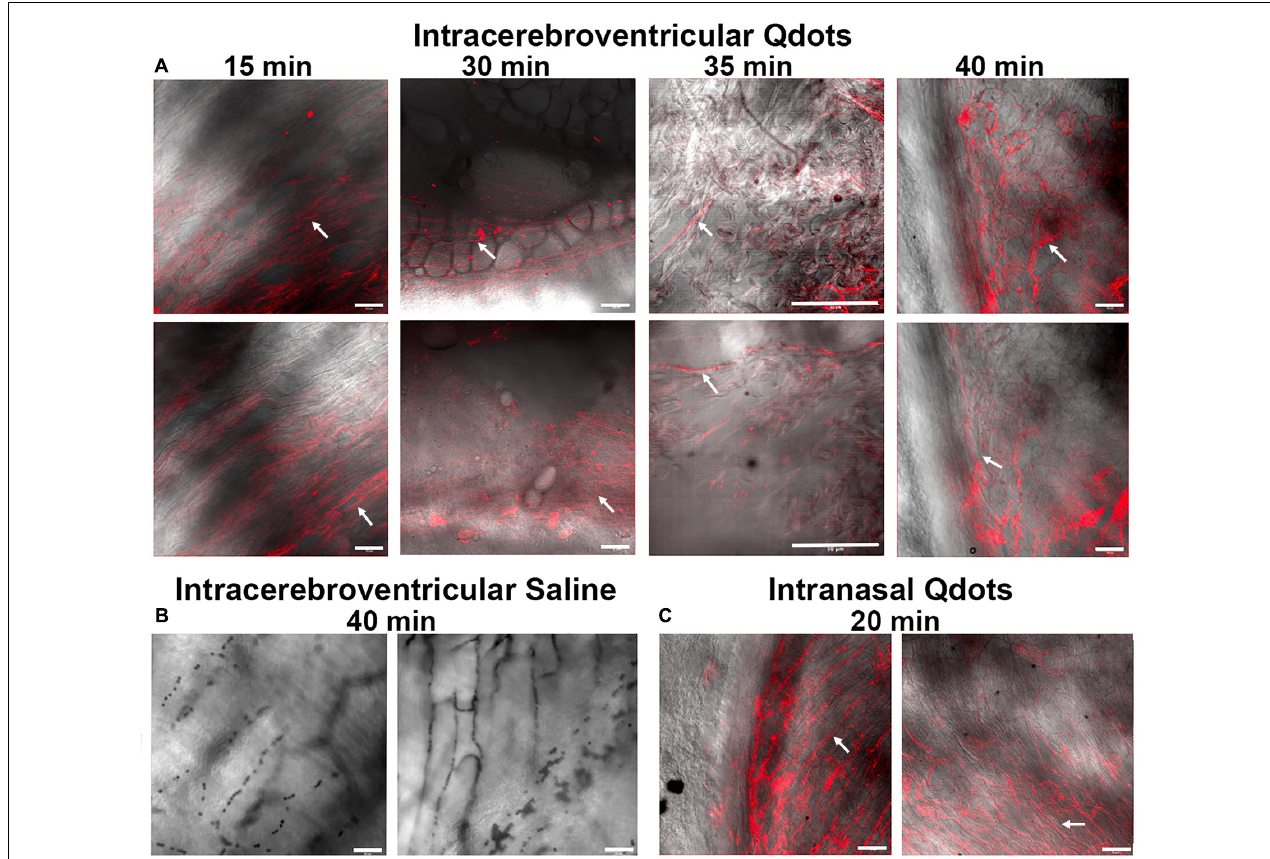
FIGURE 3 | Fluorescent images of the lumen of the upper esophagus. Shown in the upper panel (A) are photomicrographs of the lining of the esophagus from ex vivo tissue taken at different times following ICV infusion of Qdots. Each time point displays two images from different areas of the esophagus. The 15-min sample was collected from a female rat infused with 10 µ l of Qdots, while the 30- and 35-min samples are from females infused with 20 µ l of Qdots. The 40-min data were collected from a male infused with 10 µ l of Qdots. The lower left panel (B) shows photomicrographs of esophagus from a male rat infused with 10 µ l of 0.9% NaCl (saline) taken with Zeiss LSM 880 confocal microscope held at the same fluorescent threshold as the other images. The lower right panel (C) shows the presence of Qdots in the esophagus of a male rat following 1- µ l injections of Qdots into each nostril. White arrows point to the putative linear threads and strands of Qdot accumulating in mucus. Scale bar = 50 µ